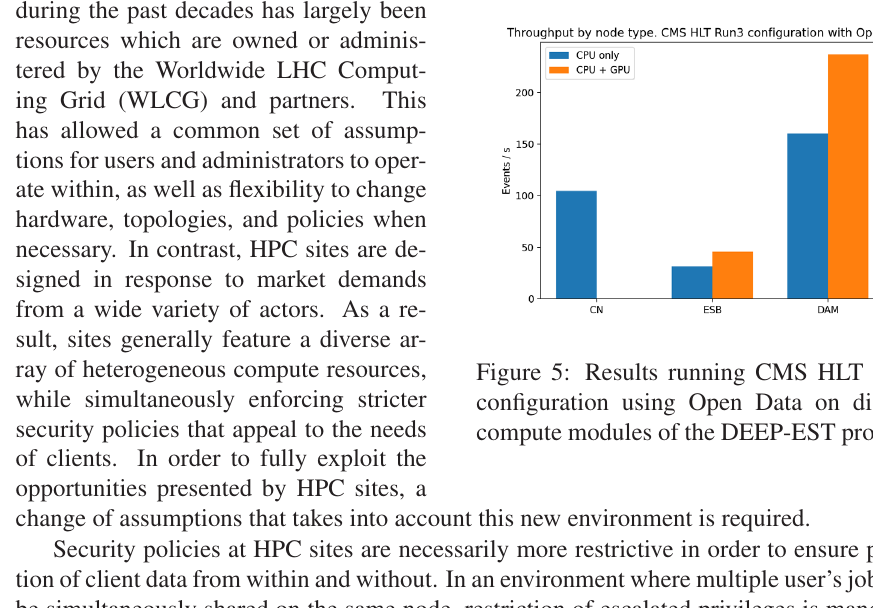
Figure 4: Ecal (a) and Hcal (b) Performance